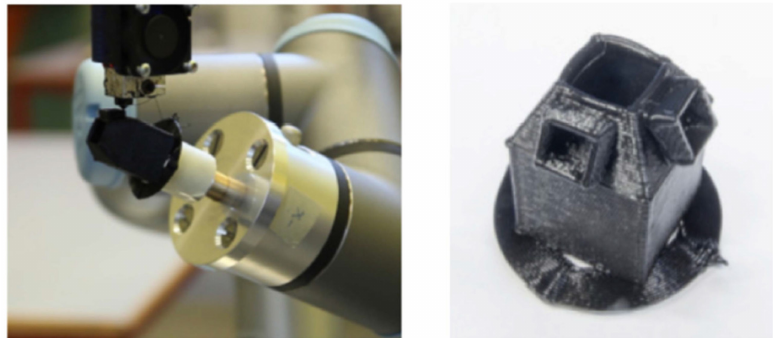
Figure 5. 5DOF AM machine ( left ) and the product fabricated without any support ( right )